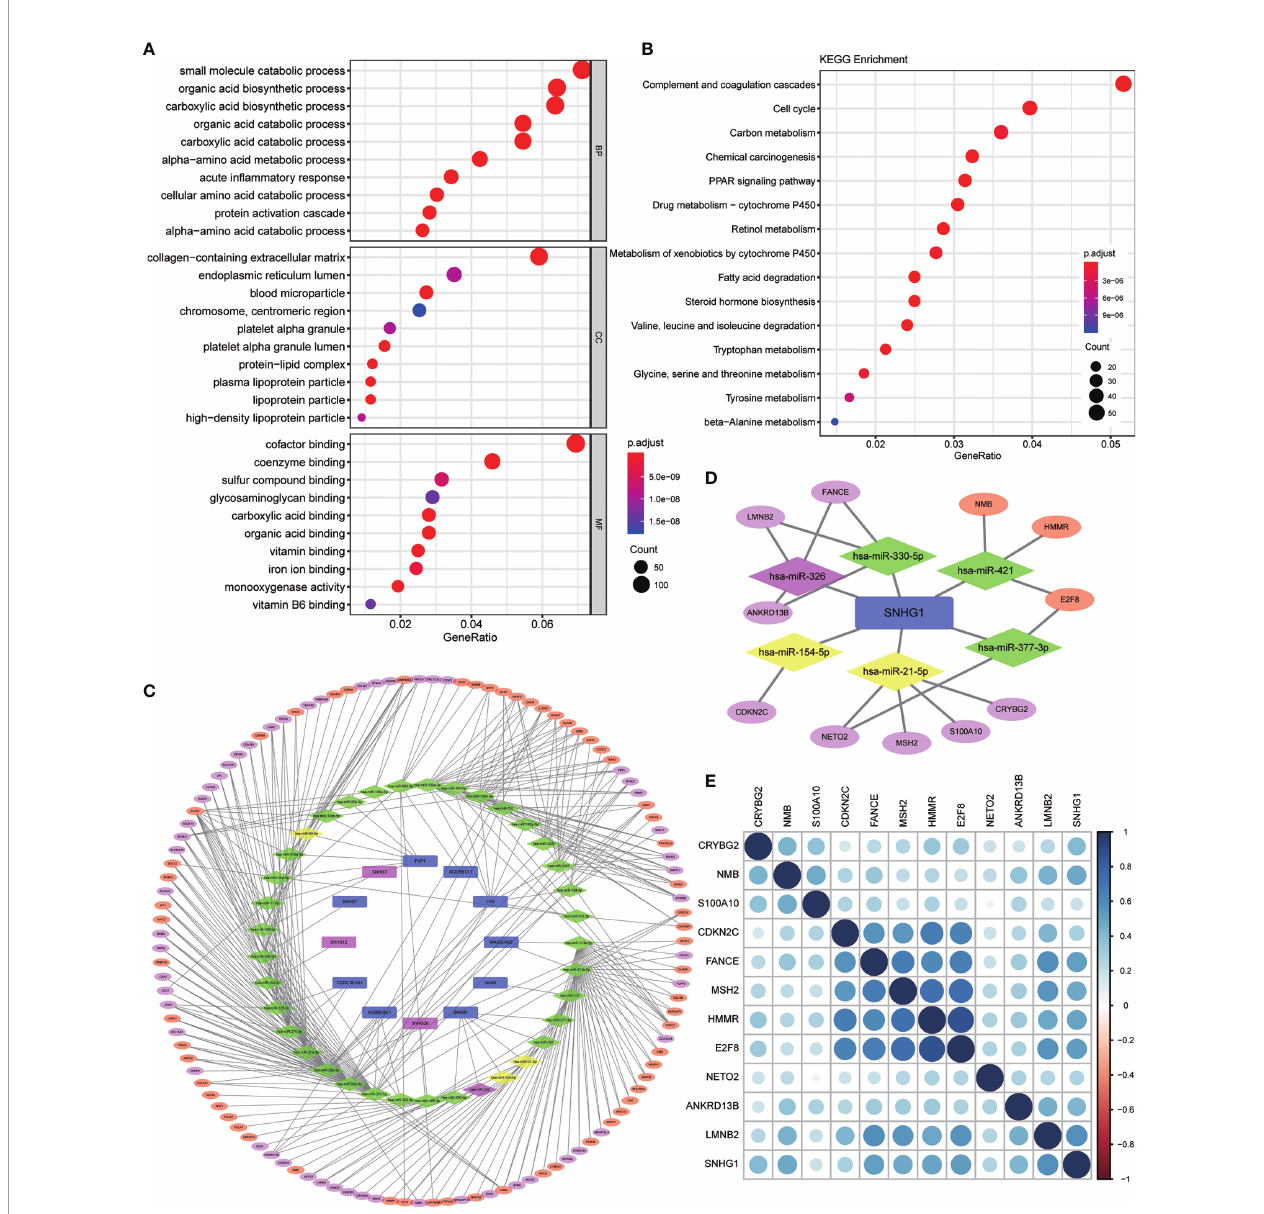
FIGURE 2 | Differential gene enrichment analysis and pathway construction. (A) Gene Ontology (GO) enrichment analysis of differentially expressed genes (BP, biological process; CC, cellular component; MF, molecular function) (p < 0.01). (B) Kyoto Encyclopedia of Genes and Genomes (KEGG) pathway analysis of differentially expressed genes (p < 0.01). (C) Competing endogenous RNA (ceRNA) network was established by Cytoscape for differentially expressed lncRNA – miRNA – mRNA. (All lncRNA nodes and mRNA nodes were differentially expressed; purple nodes were associated with survival. Yellow miRNA nodes were differentially expressed.). (D) A total of six miRNAs and 11 mRNAs were identi fi ed from the lncRNA SNHG1 -related network. (E) Heatmap for correlation matrix to visualize the gene expression correlation